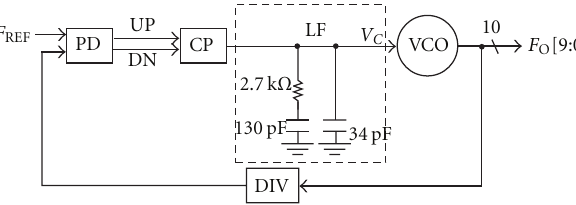
Figure 2: Conventional clock generator based on PLL.